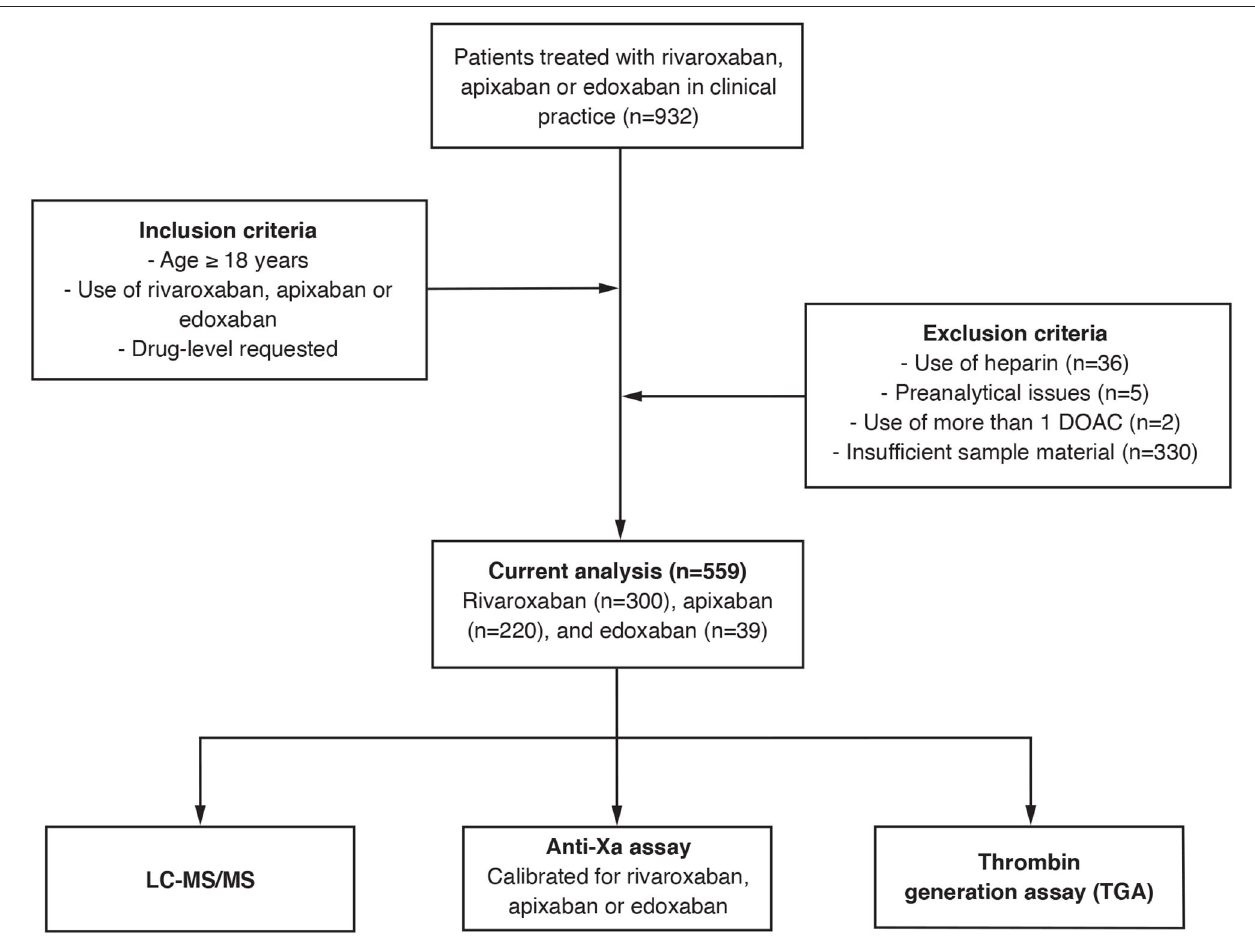
FIGURE 1 | Flow of the patients. A prospective, multicentre cross-sectional study was conducted to study the association of a state-of-the-art thrombin generation assay with rivaroxaban, apixaban, and edoxaban drug concentrations in contrast to the association obtained with an anti-Xa assay. TABLE 1 | Baseline characteristics of patients treated with rivaroxaban, apixaban or edoxaban ( n = 559). Patients treated with Rivaroxaban Apixaban Edoxaban All Missing